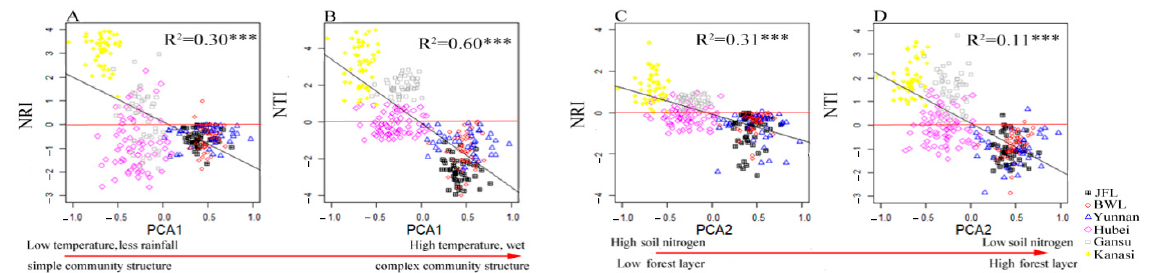
Figure 3. The relationships between phylogenetic diversity, NRI ( A , C ) and NTI ( B , D ), and com- pound habitat gradients, PC1 ( A , B ) and PC2 ( C , D ), of forest vegetation communities in China. Dif- ferent color–marker combinations represent each forest plot. The abbreviations for each variable are listed in Table 1. Significance values: ***, p < 0.001.